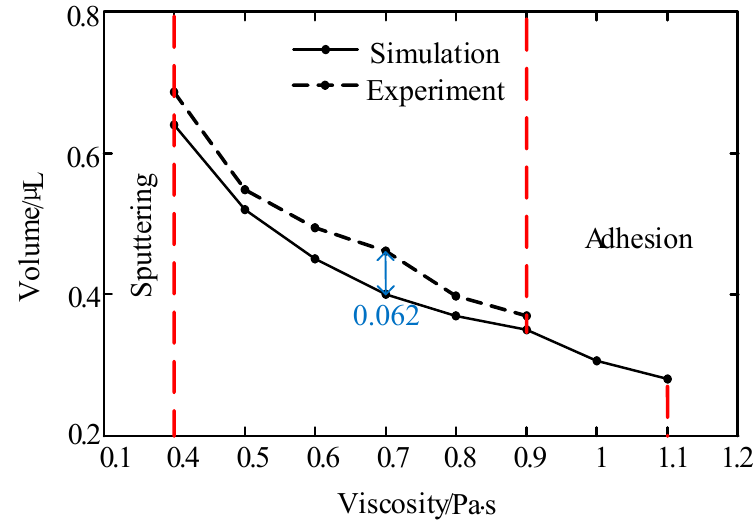
Figure 6. The influence of viscosity on the volume of the droplet. Conditions: The nozzle diameter is 0.2 mm, the needle stroke is 0.3 mm, the frequency is 20 Hz, and the pressure is 0.6 MPa.